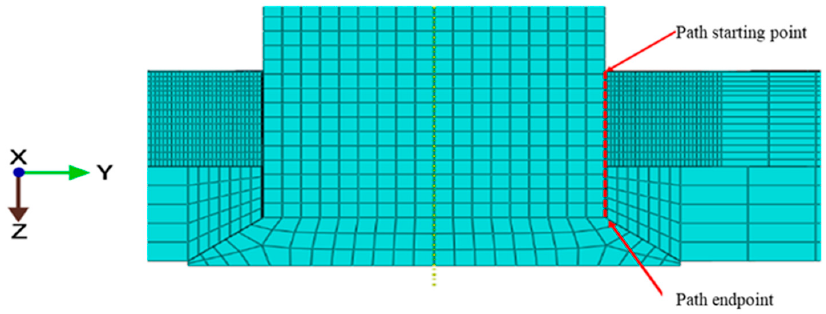
Figure 7. Rivet interference path position.